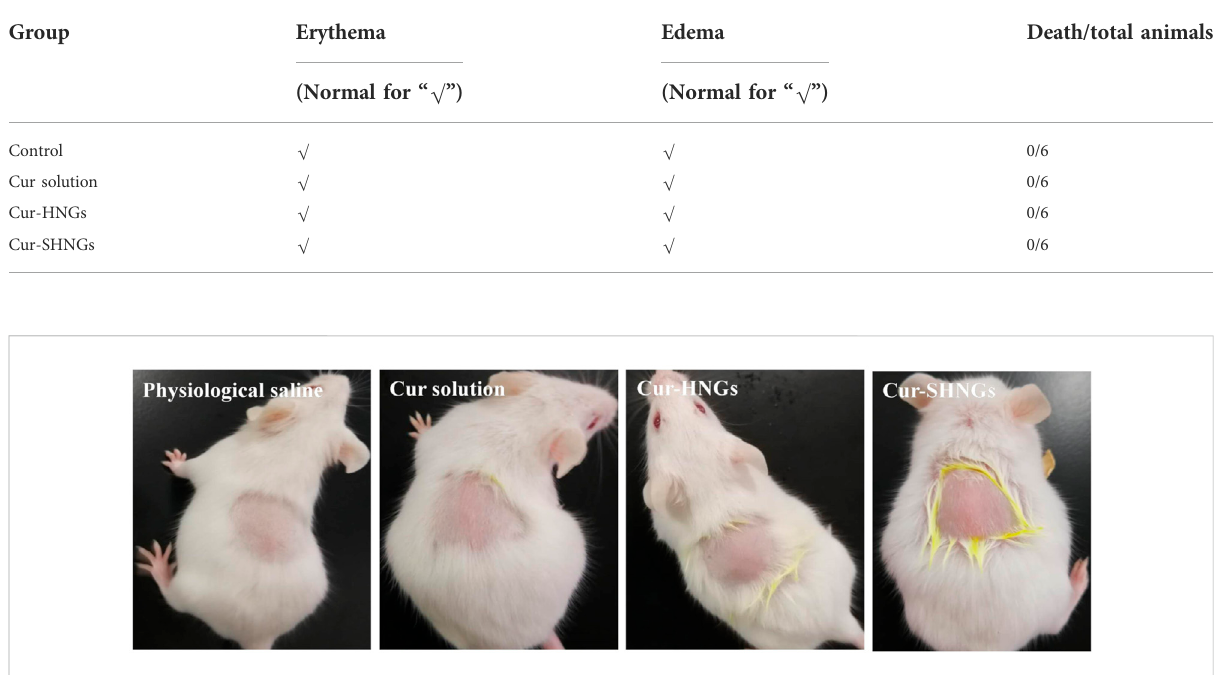
FIGURE 9 Observation of mice skin appearance at 72 h after exposure to physiological saline, Cur solution, Cur-HNGs, or Cur-SHNGs ( n =